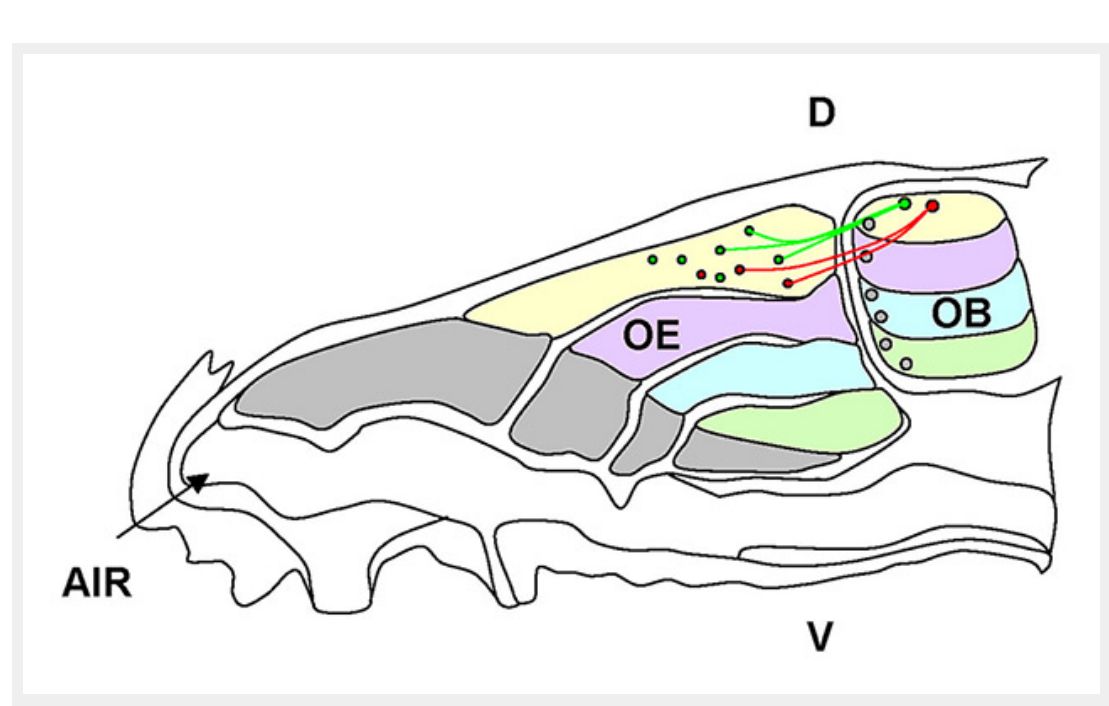
Figure 1 Schematic of the olfactory sensory neuron (OSN) projections to the olfactory bulb (OB). The olfactory epithelium (OE) is divided in zones along the dorso-ventral axis, which are defined by the expression of the odorant receptors (ORs). OSNs expressing the same receptor (red or green) are confined within a zone and project their axons to a corresponding area (along the dorso-ventral axis) of the olfactory bulb. D = dorsal; V =